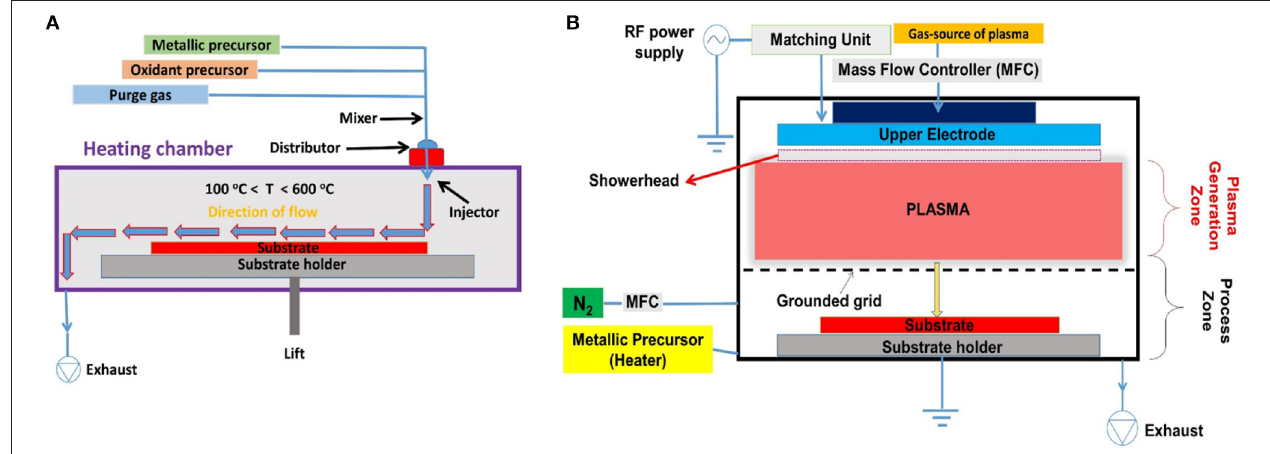
FIGURE 2 | Schematic diagram of the ALD tools: (A) cross-flow thermal ALD and (B) capacitively coupled plasma reactor used for PEALD processes at remote plasma